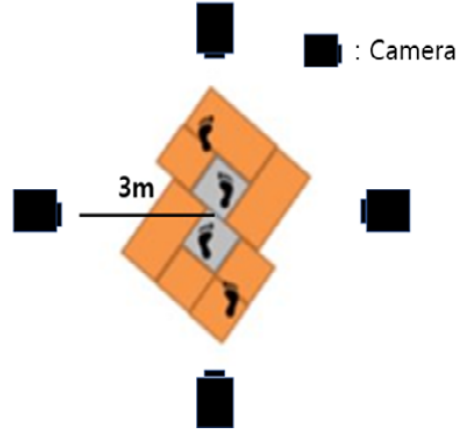
Figure 1. The experimental environment.